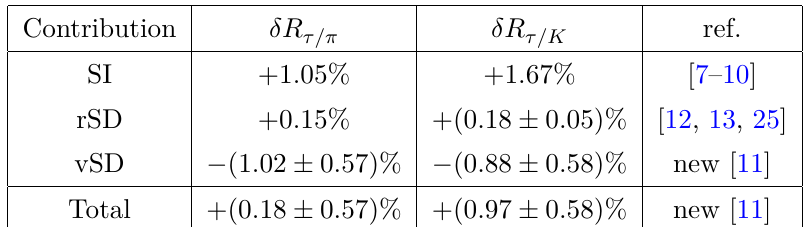
Table 2 . Numerical values of the different photonic contributions to δR (SI), real-photon Structure Dependent (rSD) and virtual-photon Structure Dependent (vSD) [11]. We do not report uncertainties for contributions where the errors are lower than